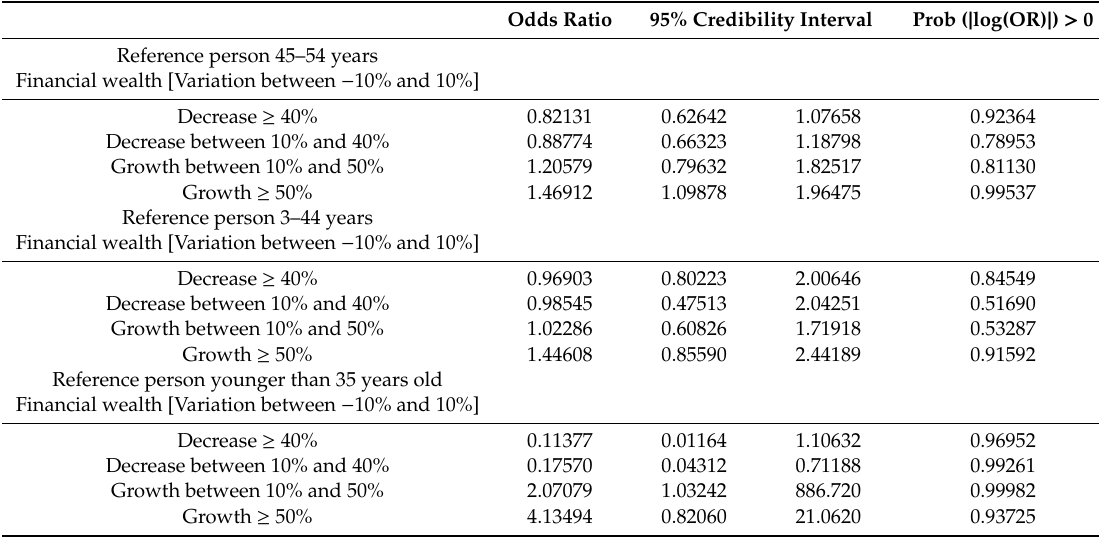
Association between the variation in financial wealth and good and very good self-perceived